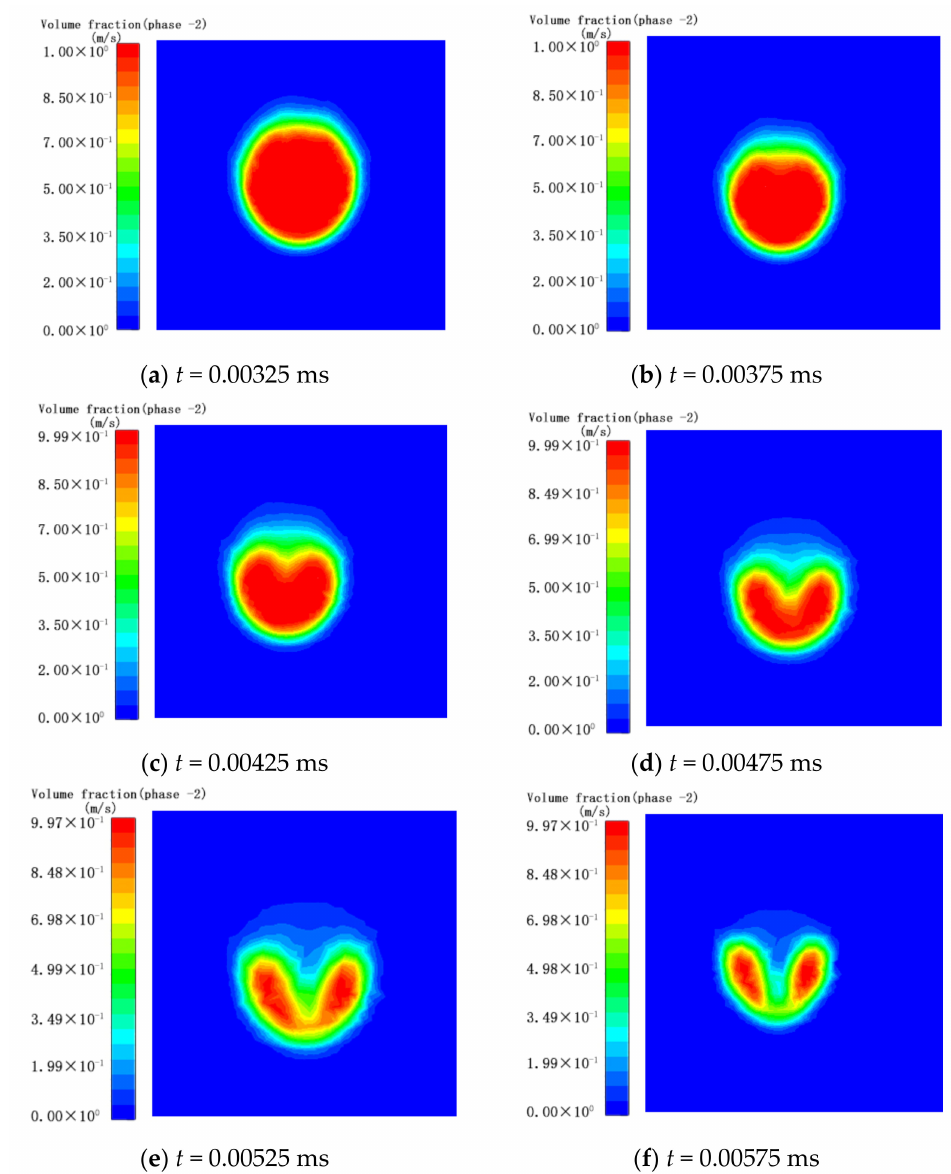
Figure 3. Simulation results of ultrasonic cavitation of bubbles near the wall. As shown in Figure 4, as the bubble radius increases from 50 µ m to 100 µ m, the maximum velocity of bubble collapse gradually increases, but the difference between the maximum velocity values is not large. This is because, under the action of ultrasonic sound pressure, the larger the bubble radius is, the greater the initial potential energy of the bubble, and the faster the bubble shrinks when it releases the potential energy; thus, the velocity of the microjet increases. Therefore, in the experiment, the initial radius of the bubble was selected as 100 µ m to achieve better experimental